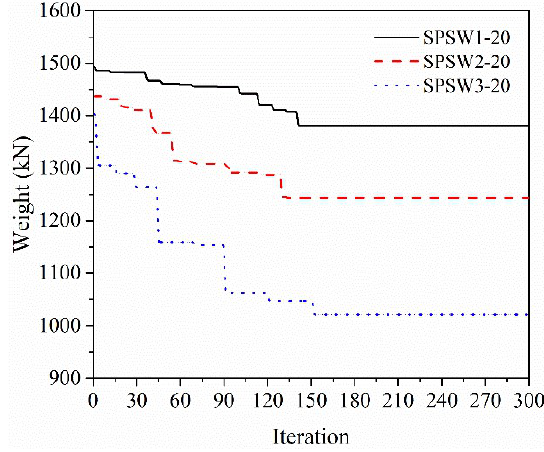
Figure 15. Convergence histories of 20-story steel frame. The total best weights of SPSW3-20 were 26.06% and 17.89% lighter than those of SPSW1-20 and SPSW2-20, respectively. The average percentages of story shear resisted by